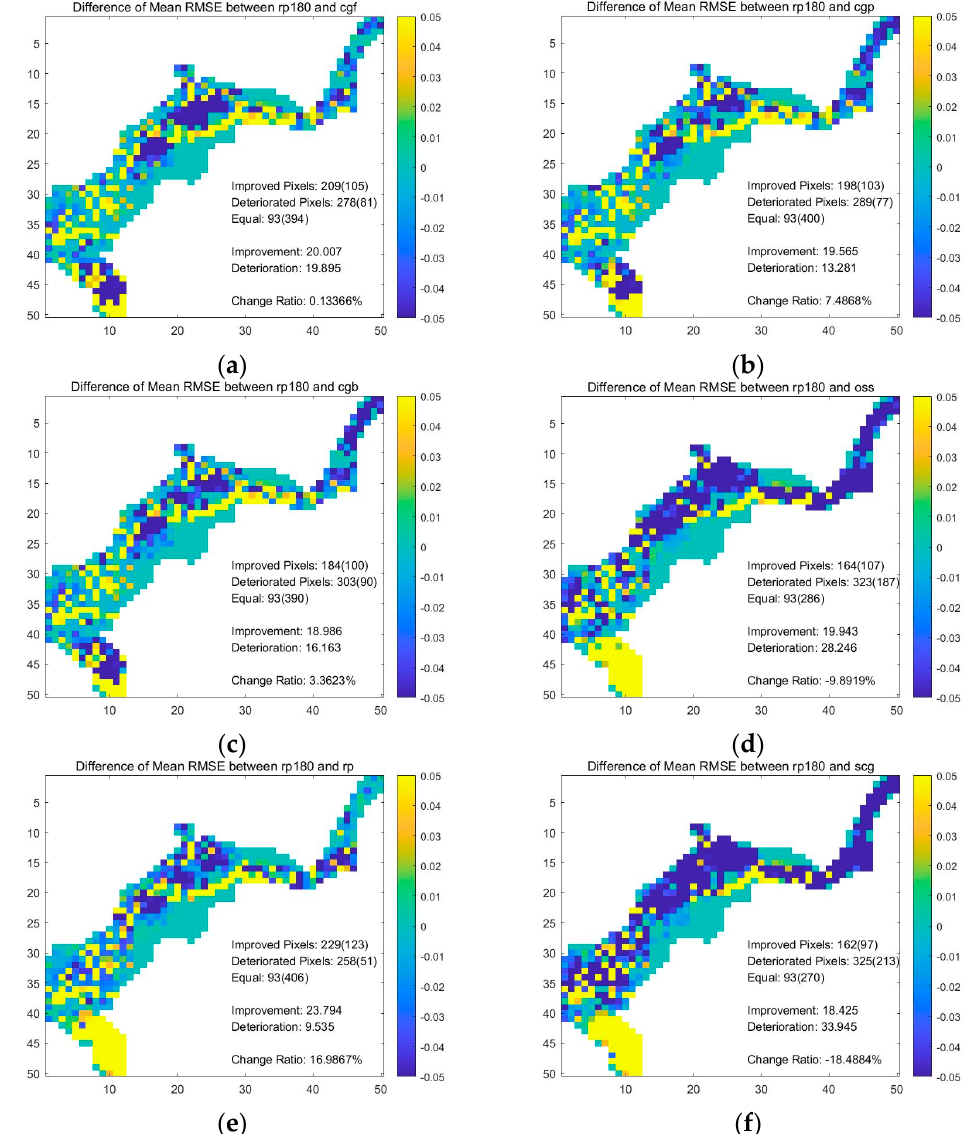
Figure A2. ( a ) Difference of mean RMSE on testing dataset between the set of RP (SD) and CGF ANN; ( b ) Difference of mean RMSE on testing dataset between the set of RP (SD) and CGP ANN; ( c ) Difference of mean RMSE on testing dataset between the set of RP (SD) and CGB ANN; ( d ) Dif- ference of mean RMSE on testing dataset between the set of RP (SD) and OSS ANN; ( e ) Difference of mean RMSE on testing dataset between the set of RP (SD) and RP ANN; ( f ) Difference of mean RMSE on testing dataset between the set of RP (SD) and SCG ANN.